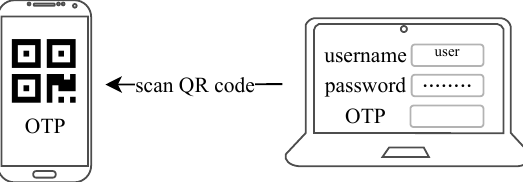
Figure 9. The application scans the QR code containing the OTP and obtains the OTP.